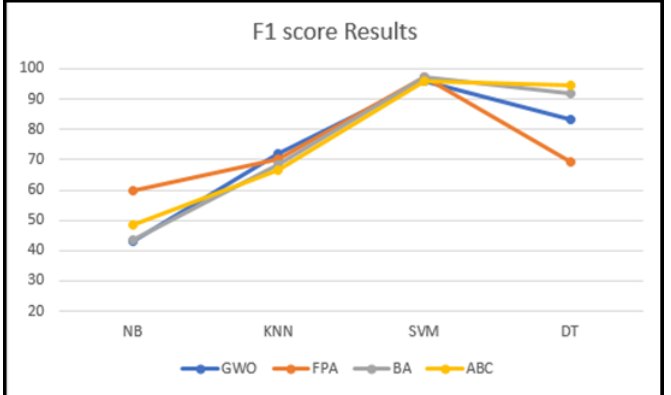
Figure 6. Comparison of F1 score results between proposed models on the GE dataset.